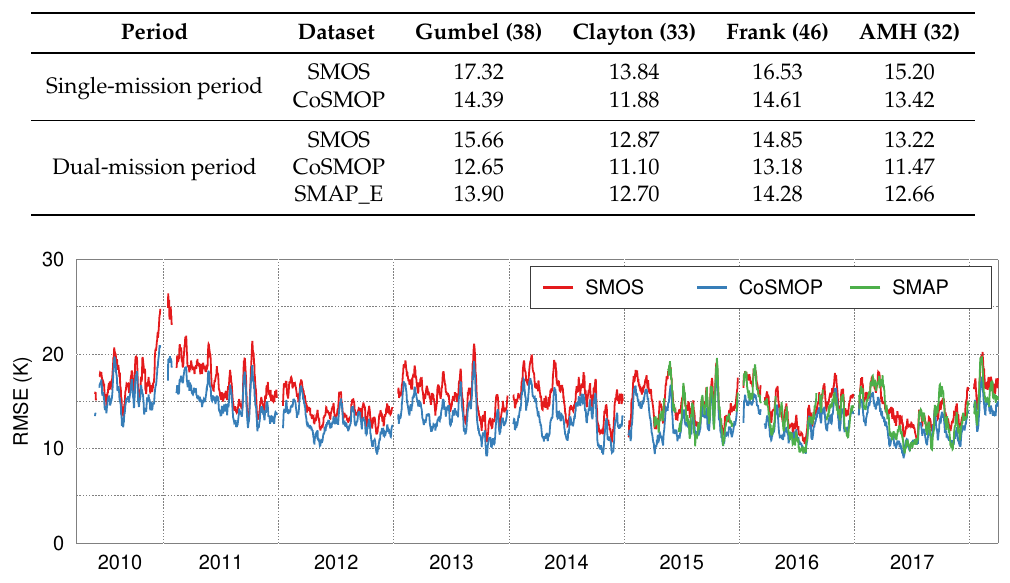
Table 2. Average RMSE (K) for each copula over all SCAN stations in the CONUS region. The number in the brackets shows the number of stations where a specific copula has been identified. The two top rows show the values for the validation (i.e., pre-SMAP) period, while the three bottom rows correspond to the calibration period.